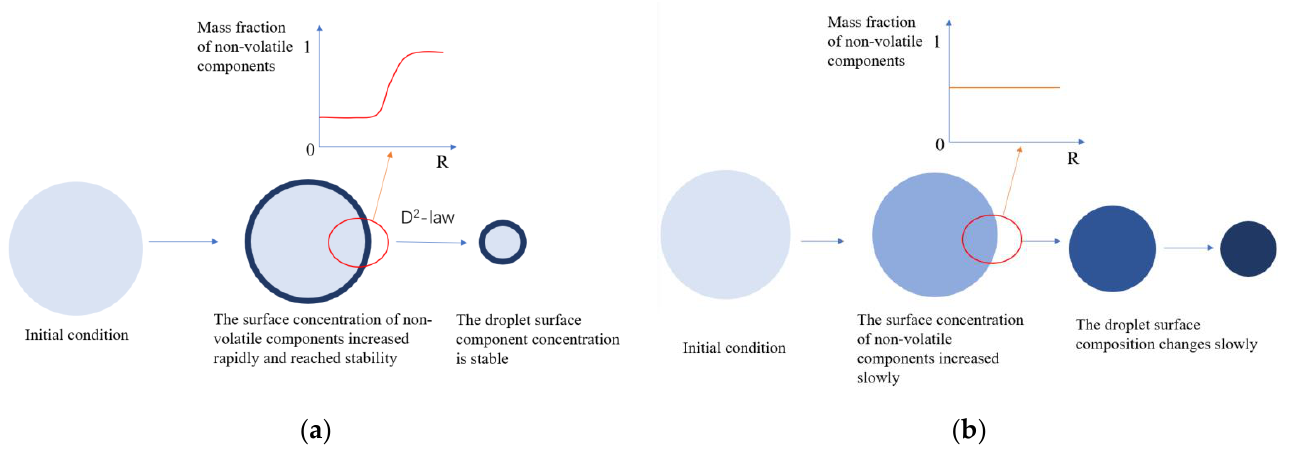
Figure 4. Diagrams of droplet evaporation process at different temperatures: ( a ) higher tempera- tures (>573 K); ( b ) lower temperature (473 K). (>573 K); ( b ) lower temperature (473 K).